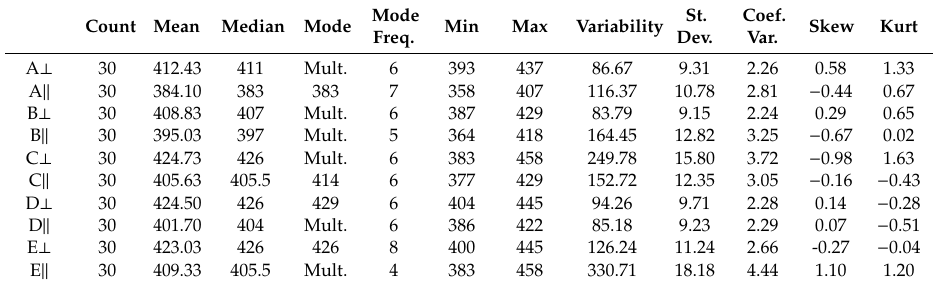
Table 1. Descriptive statistics of hardness measurement.